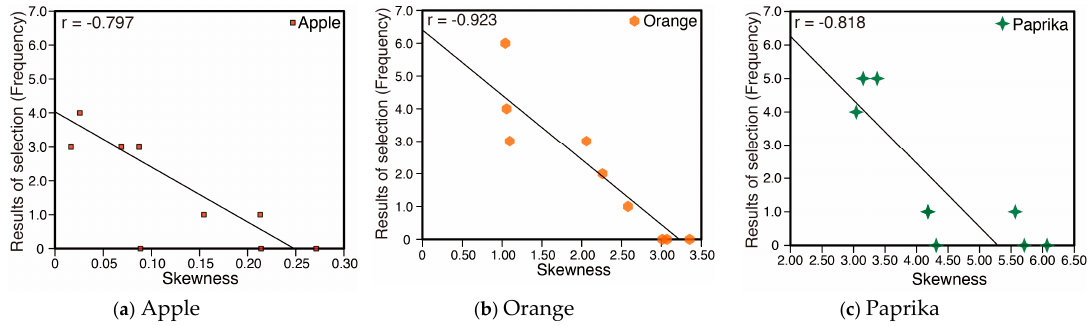
Figure 22. Correlation between the skewness of luminance histogram and fidelity selection. ( a ) Apple, ( b ) Orange, ( c ) Paprika.